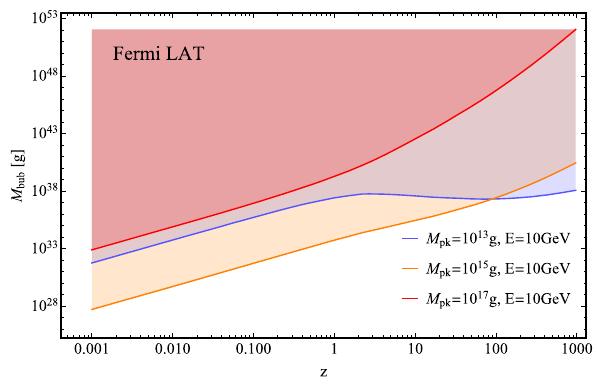
Fig. 4 The parameter space of the redshift z and bubble mass M bub allowed by Fermi LAT (the shaded regions) with the photon energy E = 10 GeV and peak masses M pk = 10 13 , 10 15 , 10 17 g, respectively